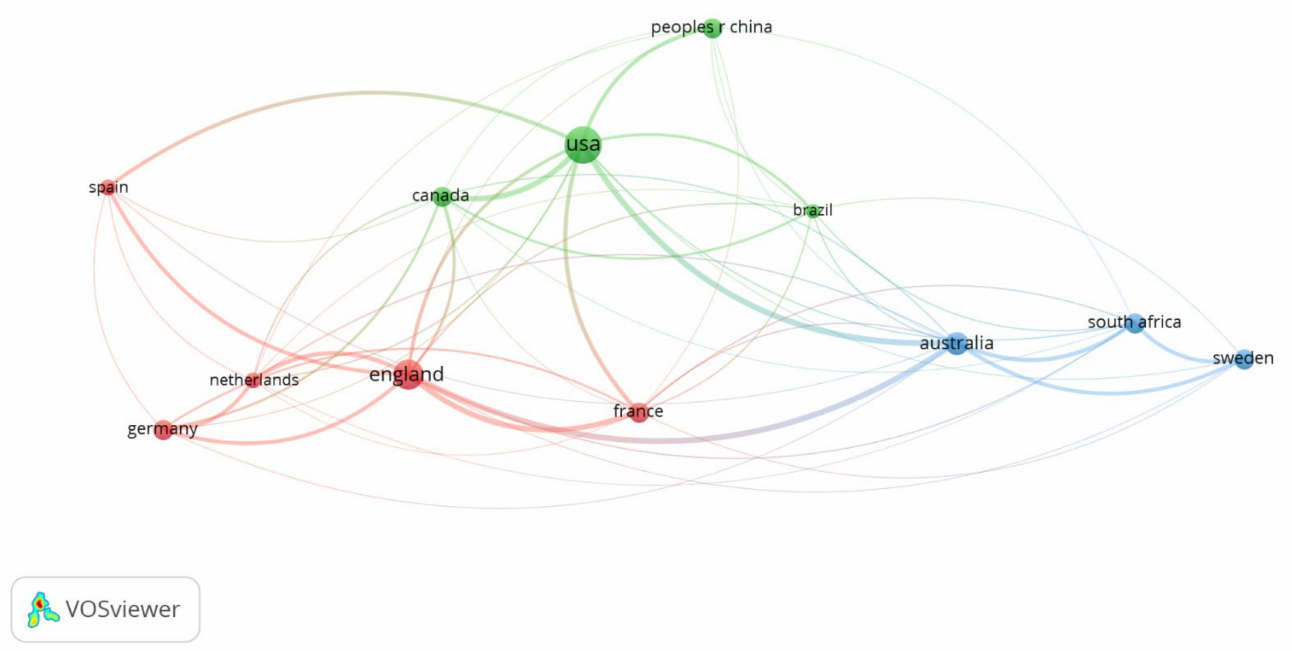
Figure 4. Co-authorship network of the top countries related to ecosystem services research in Web of Science Core Collection (WoSCC) database obtained by the highly cited journals from 2000 to 2020. Note: The threshold value = 1, applied for highly cited articles of 128, resulting in 12 countries. The bubble size shows the total number of highly cited articles, the line thickness shows the linkage’s strength, and the color shows the